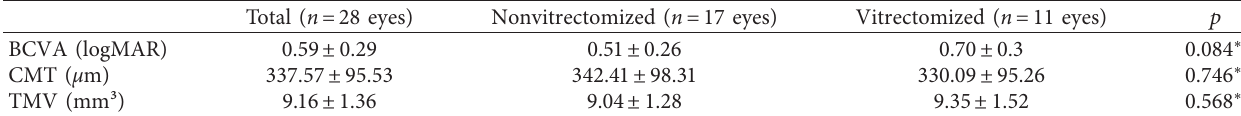
Table 2: Baseline ocular measurements of the study groups.